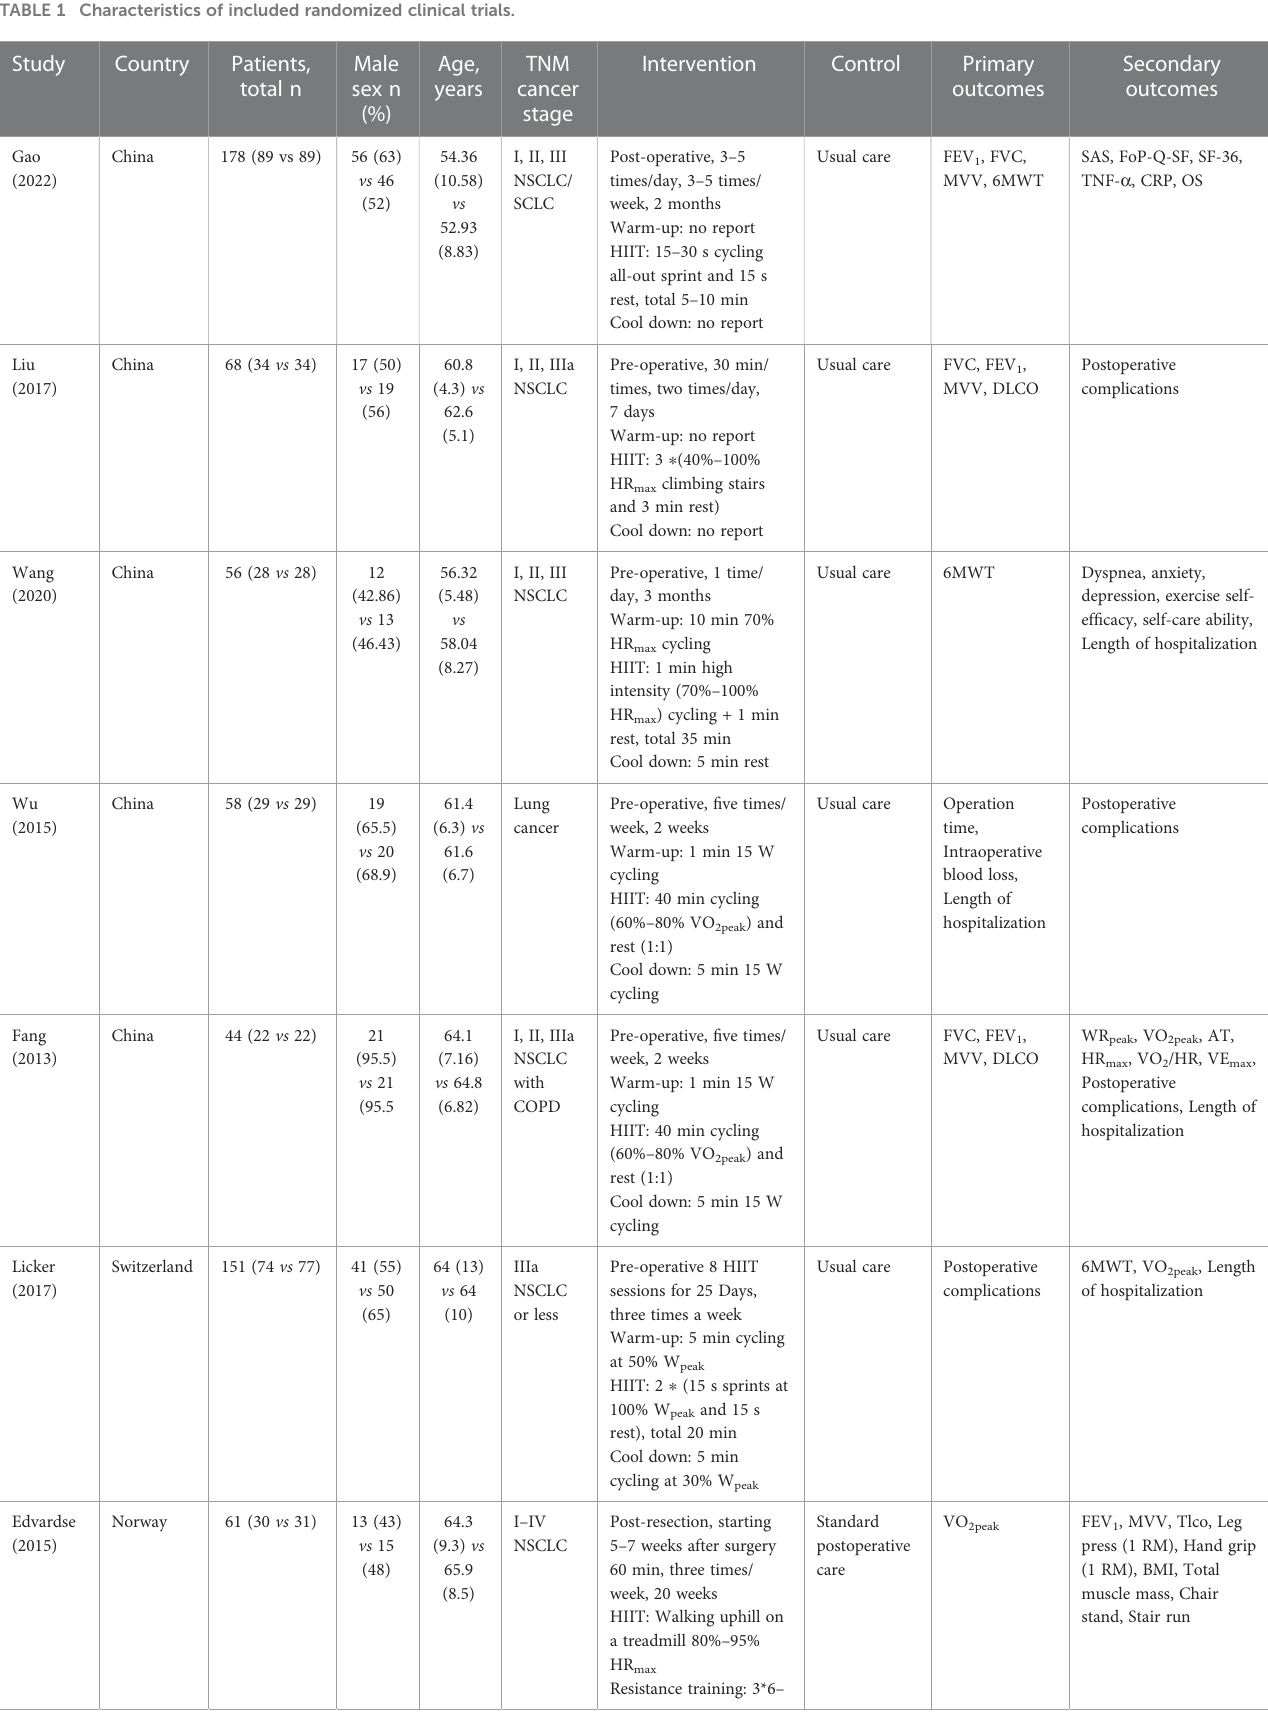
TABLE 1 Characteristics of included randomized clinical